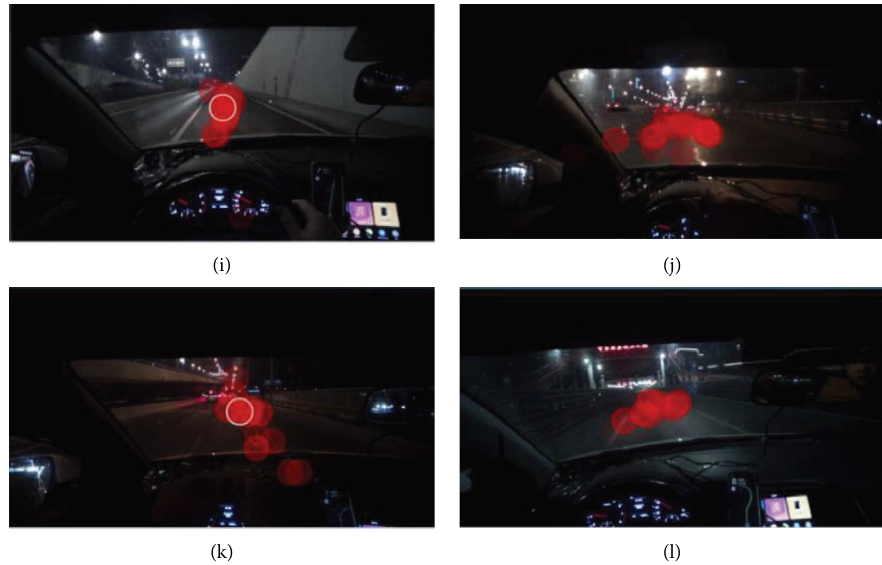
Figure 11: Gaze regions at diferent positions during the night. (a) T1-1 (0m), (b) T2-1 (2900 m), (c) T3-1 (5600m), (d) T1-2 (400 m), (e) T2-2 (4700m), (f) T3-2 (6000 m), (g) T1-3 (1200m), (h) T2-3 (5050 m), (i) T3-3 (8700 m), (j) B1-3 (1900m), (k) R-2 (2600m), and (l) B2- 1 (5300